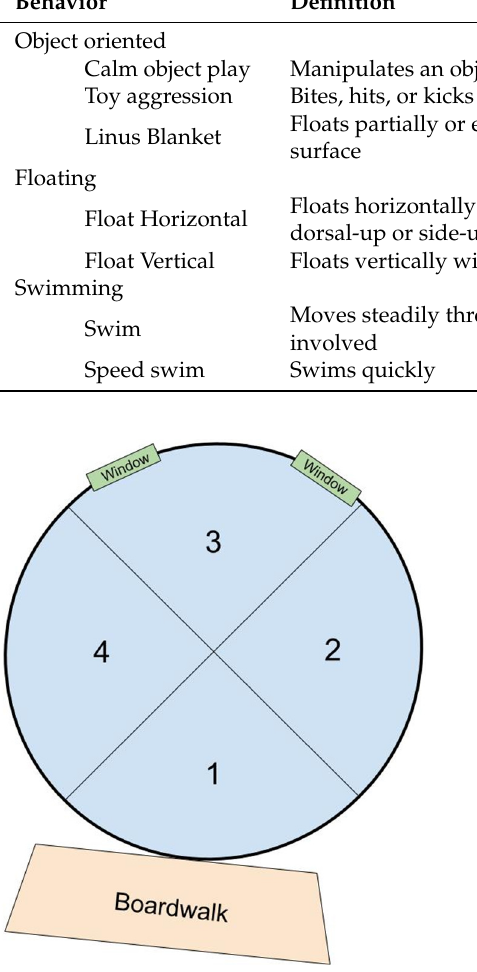
Figure 1. Medical pool diagram with quadrant locations used in observations.